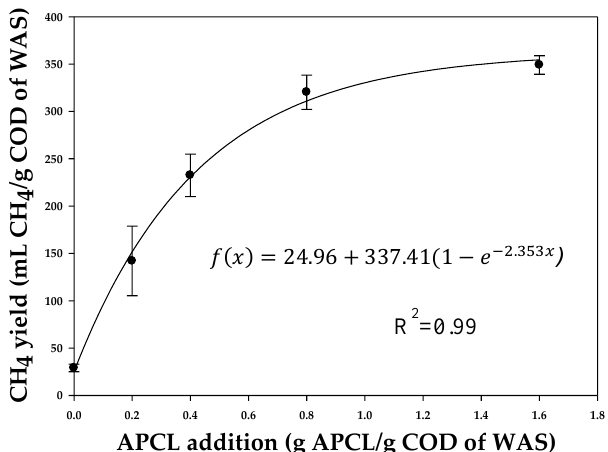
Figure 2. Changes in CH 4 yields during batch test II of waste activated sludge pretreated using different APCL additives (amylase + protease + cellulase + lipase).